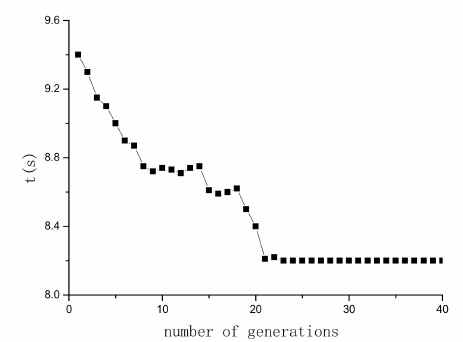
Figure 6. t 100 convergence process. The V veh,max convergence process is as in Figure 7, basically stable after near 25 generations.